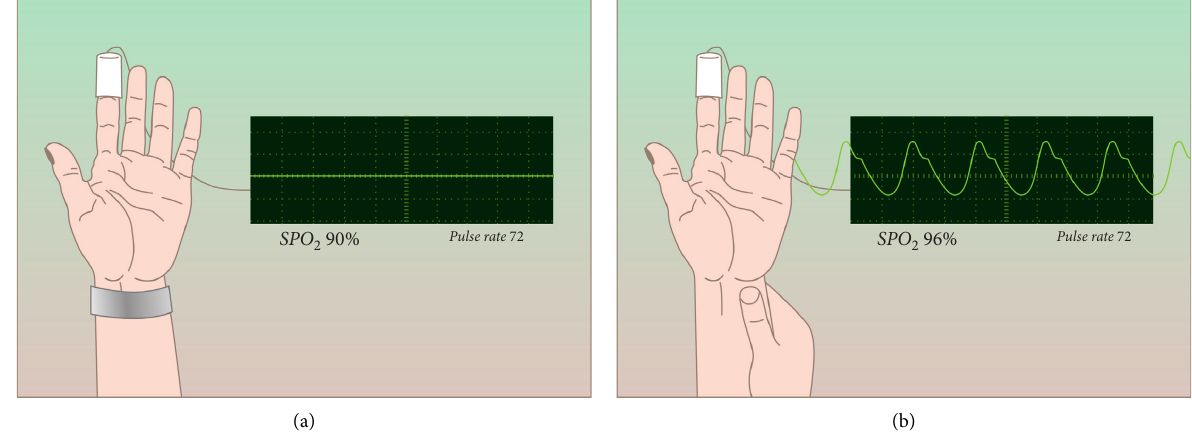
Figure 2: Scheme of radial artery recanalization. (a) Compression of the ulnar artery with TR band for one hour (no plethysmographic waveform (RAO)). (b) Repeating pulse oximeter test and recording the appearance of plethysmographic waveform indicating that re- canalization of RAO was